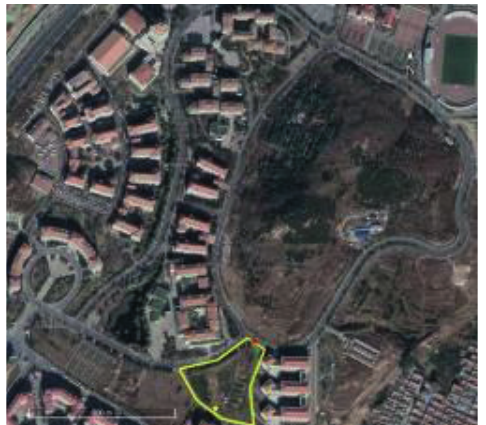
Figure 1. The Route of First Experiment (Yellow Line) and the Placement Location of WindMast WP350 (Green Star) (cid:3)